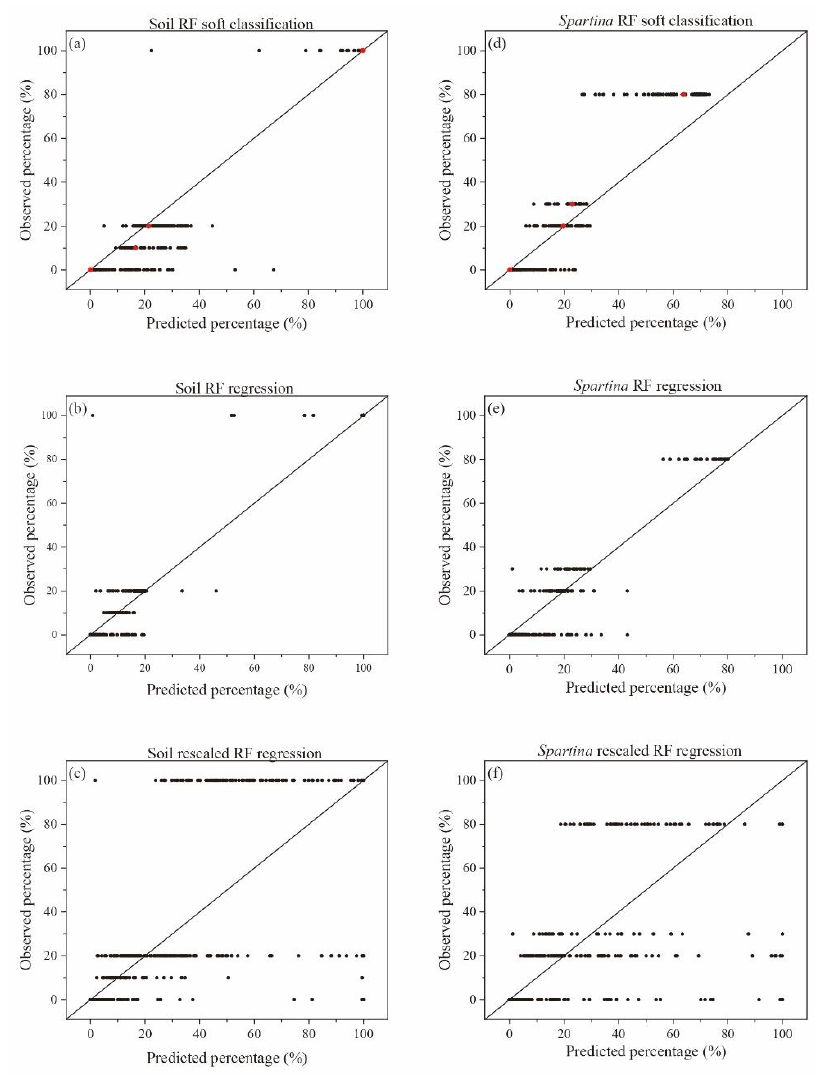
Figure 9. Validation results for Soil and Spartina : ( a , d ) are predicted probabilities (x-axis) plotted against the validation data; ( b , e ) are regression results (x-axis) plotted against the validation data; ( c , f ) are rescaled regression results (x-axis) plotted against the validation data. Red dots represent the mean of the predicted percentage using the RF soft classification.